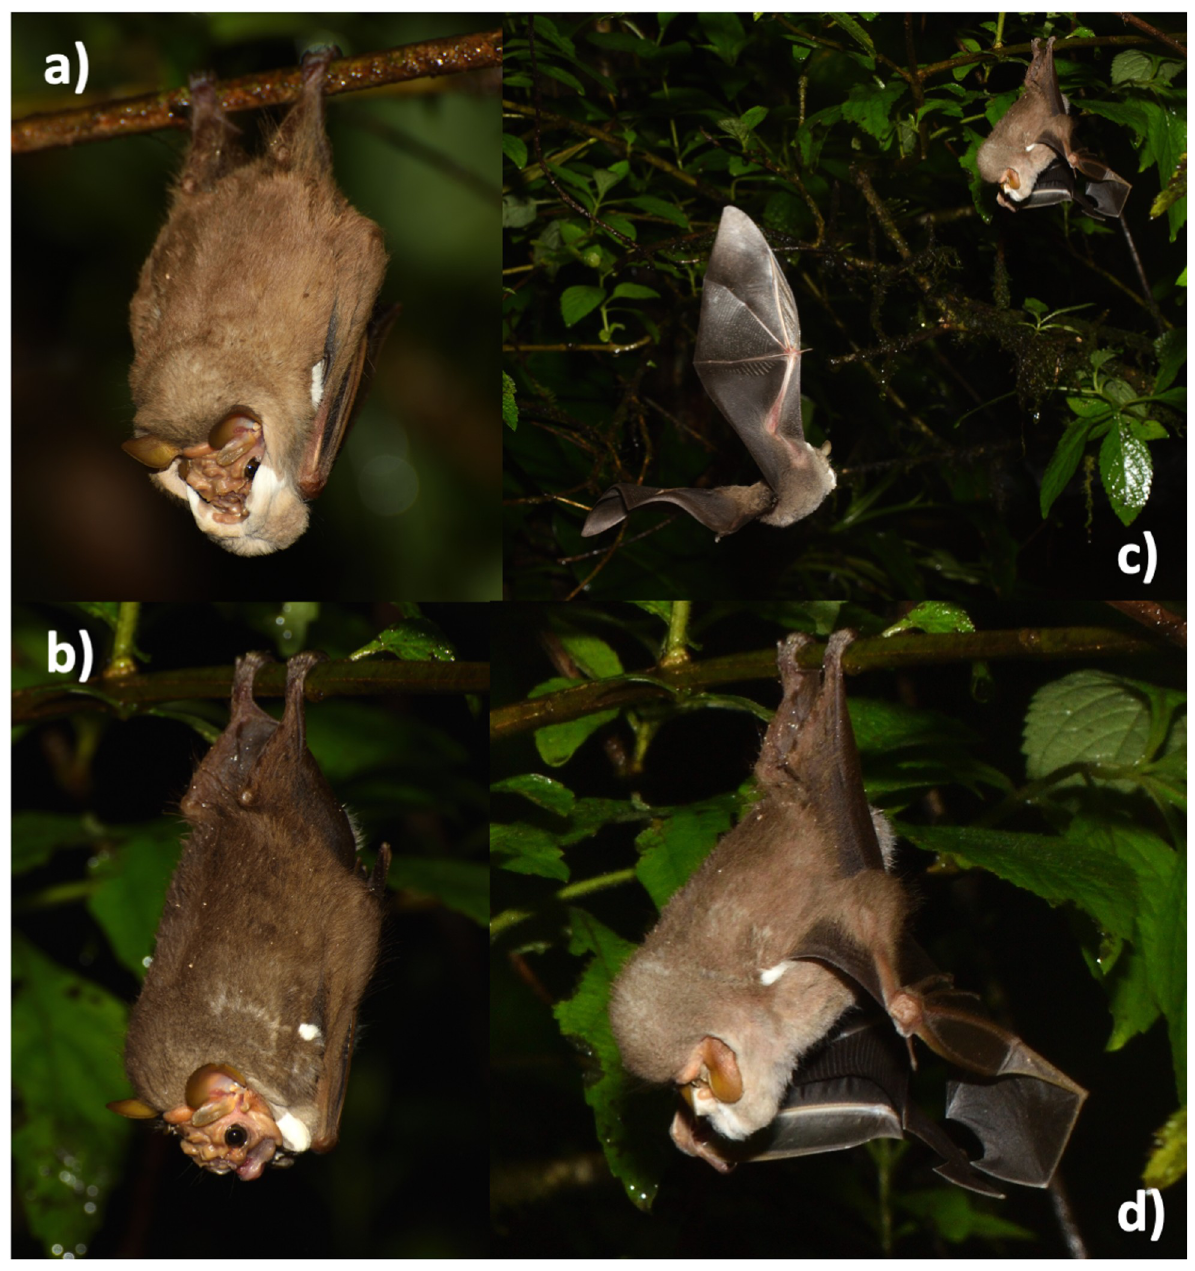
and pressed his face onto the middle of her back, in a position typical for mating in bats. The visibly vibrating male held the female, using thumb claws and wings, and seemed also to bite into the fur on the lower back of the female, presumably while penetrating. Both bats remained in this position for ca. 30 seconds, and then the female got restless and departed. The male immediately raised the mask again and returned to phase 1) behavior (S3